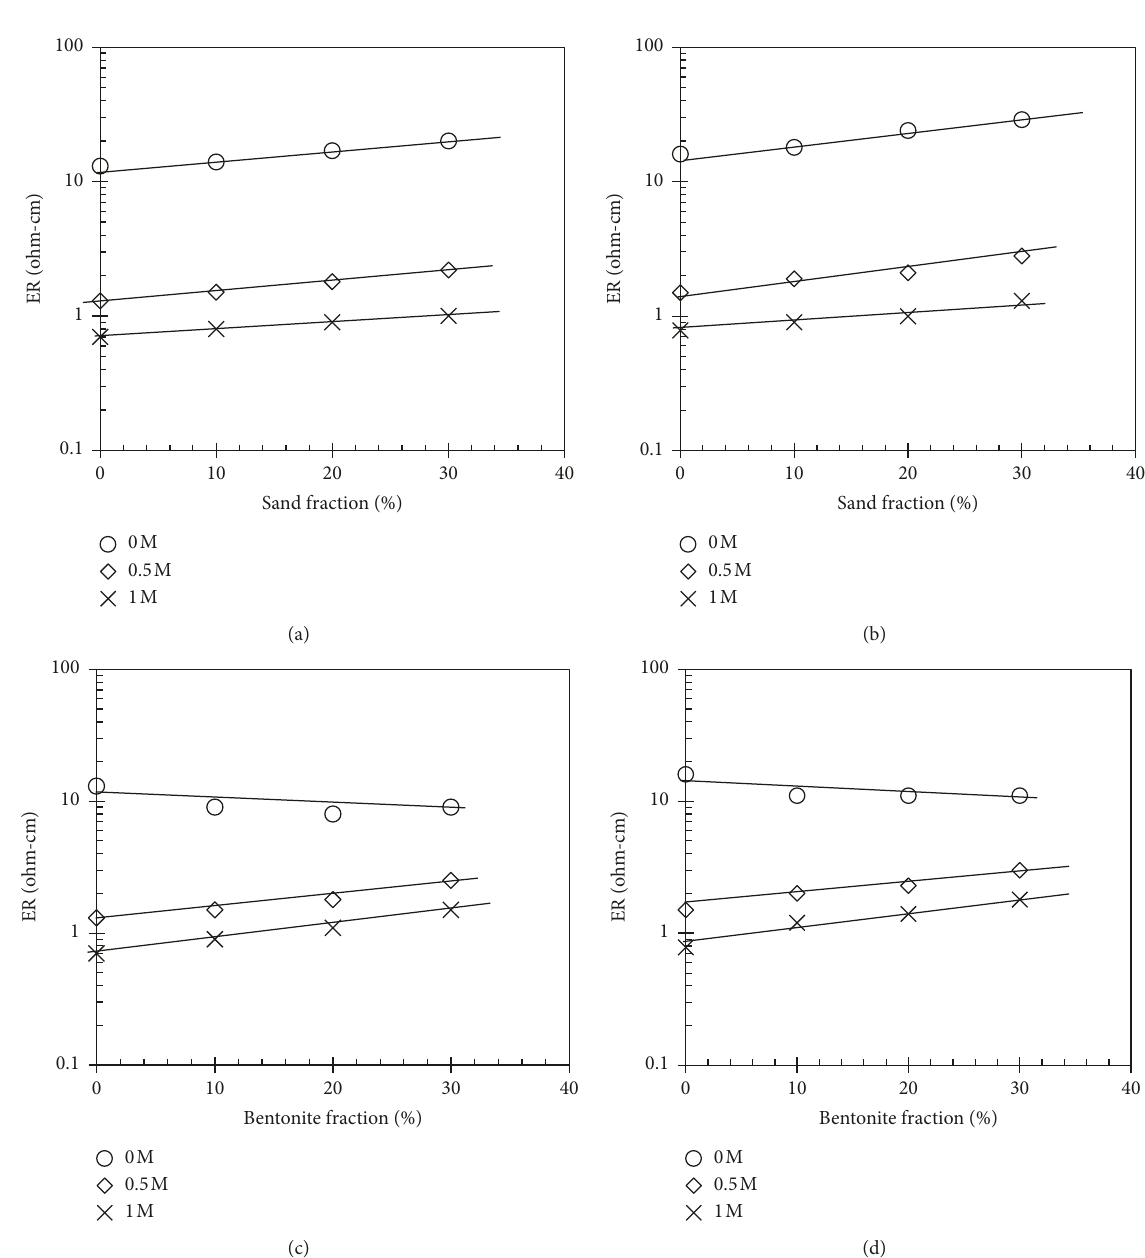
20%, ρ d 1.6 (g/cm 3 ). (b) W c (cid:31) (cid:31)